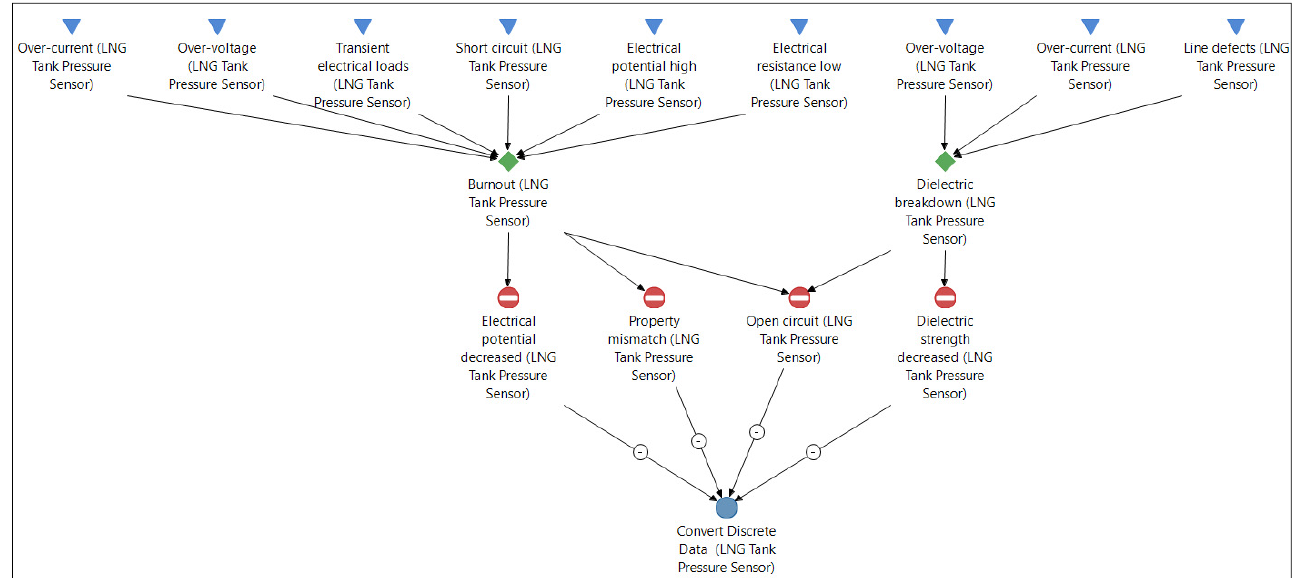
Figure 3. LNG tank pressure sensor failure diagram.